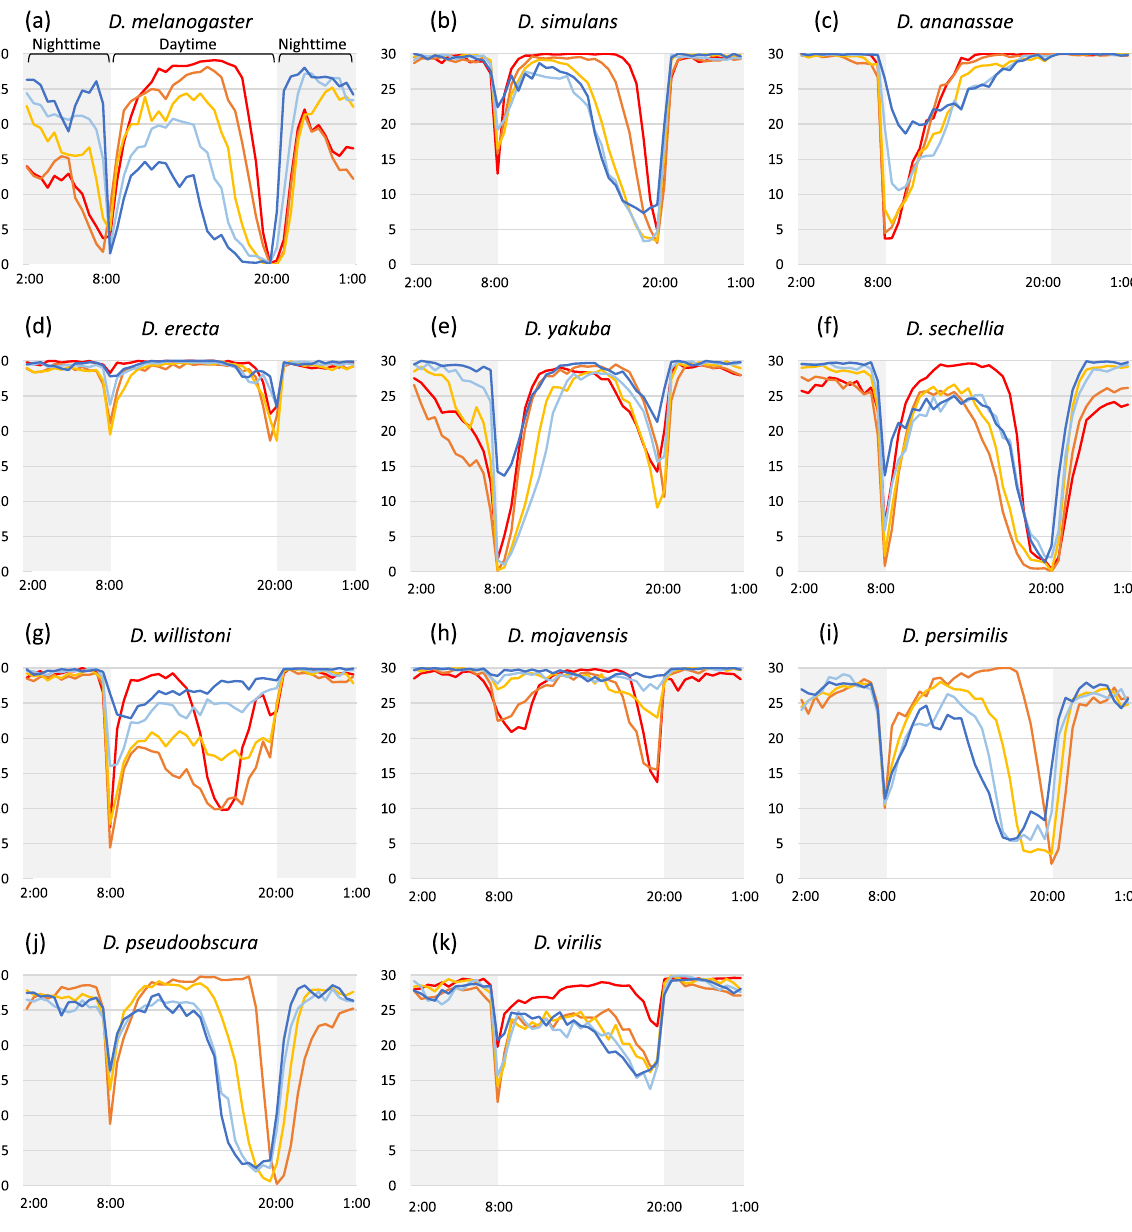
Figure 4. Profiles of daily sleep in 11 Drosophila species at five different temperatures. ( a–k ) The daily sleep profile in each species; ( a ) D. melanogaster , ( b ) D. simulans , ( c ) D. ananassae , ( d ) D. erecta , ( e ) D. yakuba , ( f ) D. sechellia , ( g ) D. willistoni , ( h ) D. mojavensis , ( i ) D. persimilis , ( j ) D. pseudoobscura , and ( k ) D. virilis . The y axis shows the duration of sleep in 30 min. The lines depict the average of sleep duration in 30 min at each temperature condition. The line color indicates experimental temperatures; dark blue:17 °C, light blue: 20 °C, light orange: 23 °C, dark orange: 26 °C, red: 29 °C. The shadow in the figure indicates the dark condition